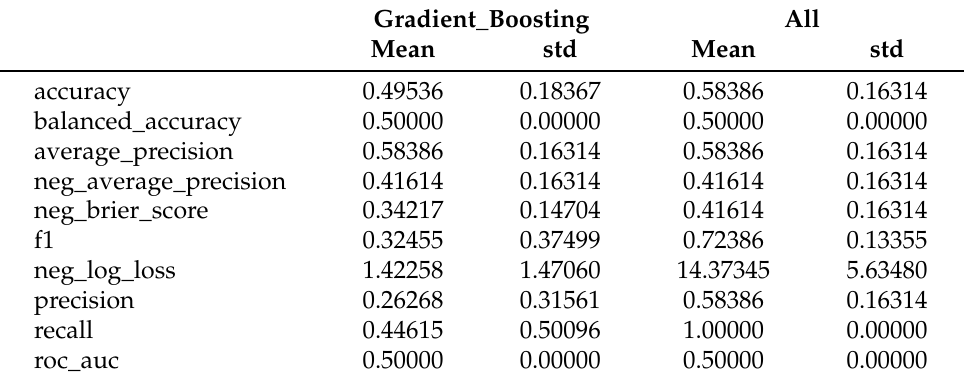
Table 1. Mean and standard deviation of the metrics on the test sets for gradient boosting (seed = 42) and the trade-always